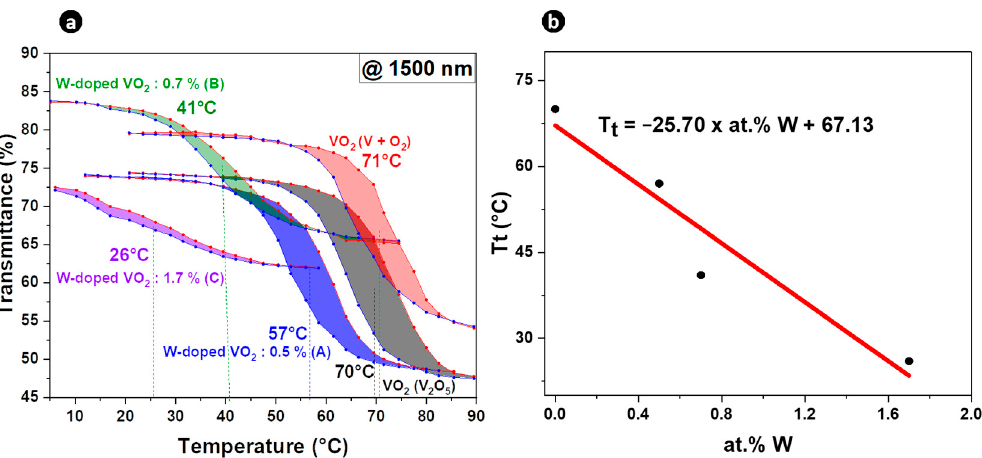
Figure 1. ( a ) Hysteresis loops derived from the temperature-dependent transmittance of the undoped and W-doped (A, B, and C) thin films at a wavelength of 1500 nm. ( b ) The correlation between the phase transition temperature T t and W concentration.